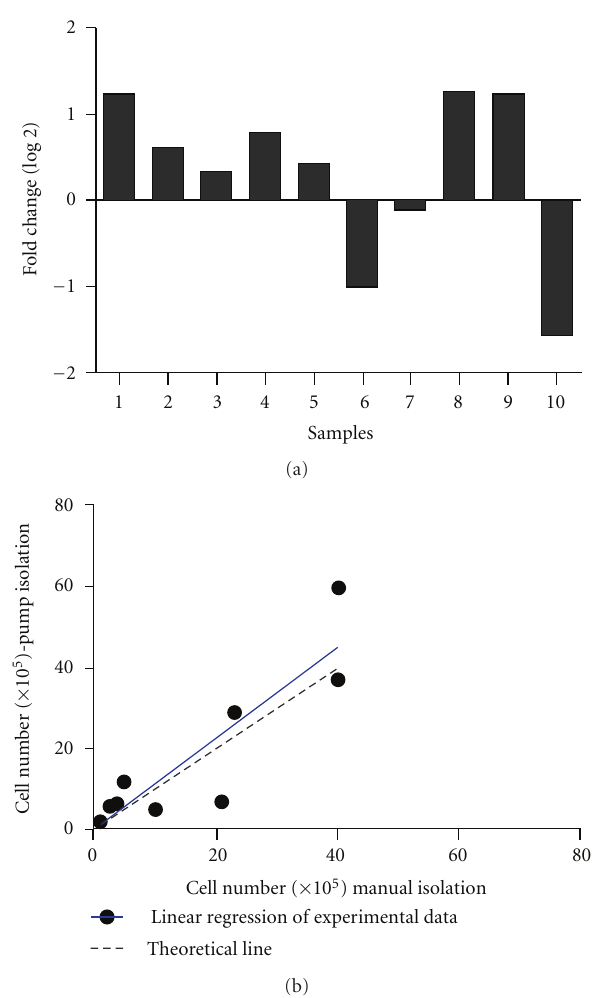
Figure 5: (a) bar graph depicting the log 2 of the fold changes between the quantity of cells obtained by pump-assisted method compared to the amount of cells obtained by manual aspiration for ten individuals. (b) linear regression model showing no statistical di ff erence in cell number depending on the liposuction method used. The di ff erence in the slopes of the linear regression of ex- perimental data (black line) is not significant ( P = 0 . 56) compared to the theoretical line (dotted line, constructed assuming there is no di ff erence between the